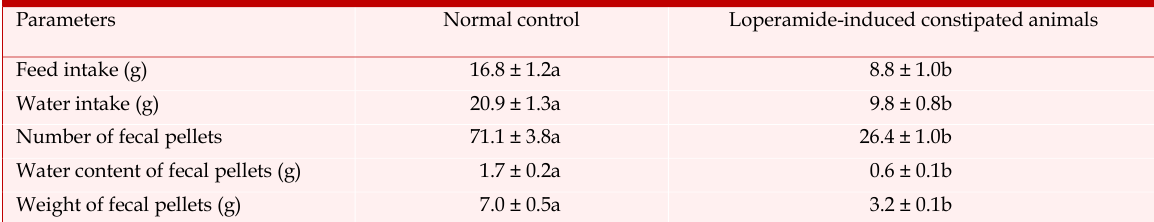
Effect of administration of loperamide on feed intake, water intake, and fecal parameters of rats Parameters